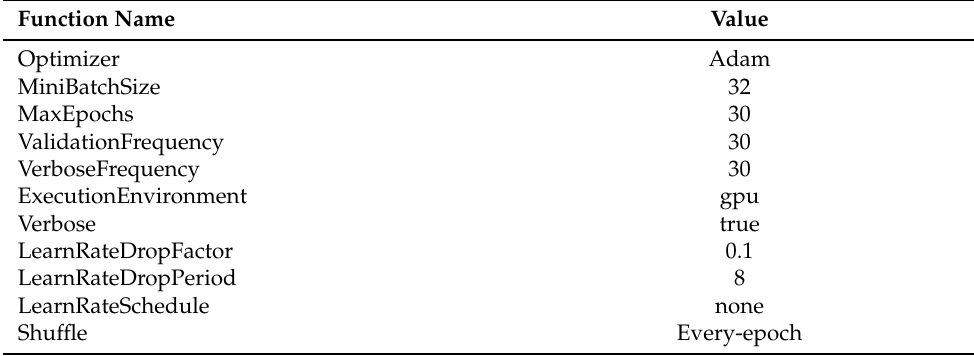
Figure 3. Sample augmented diseased images. Table 4. Training